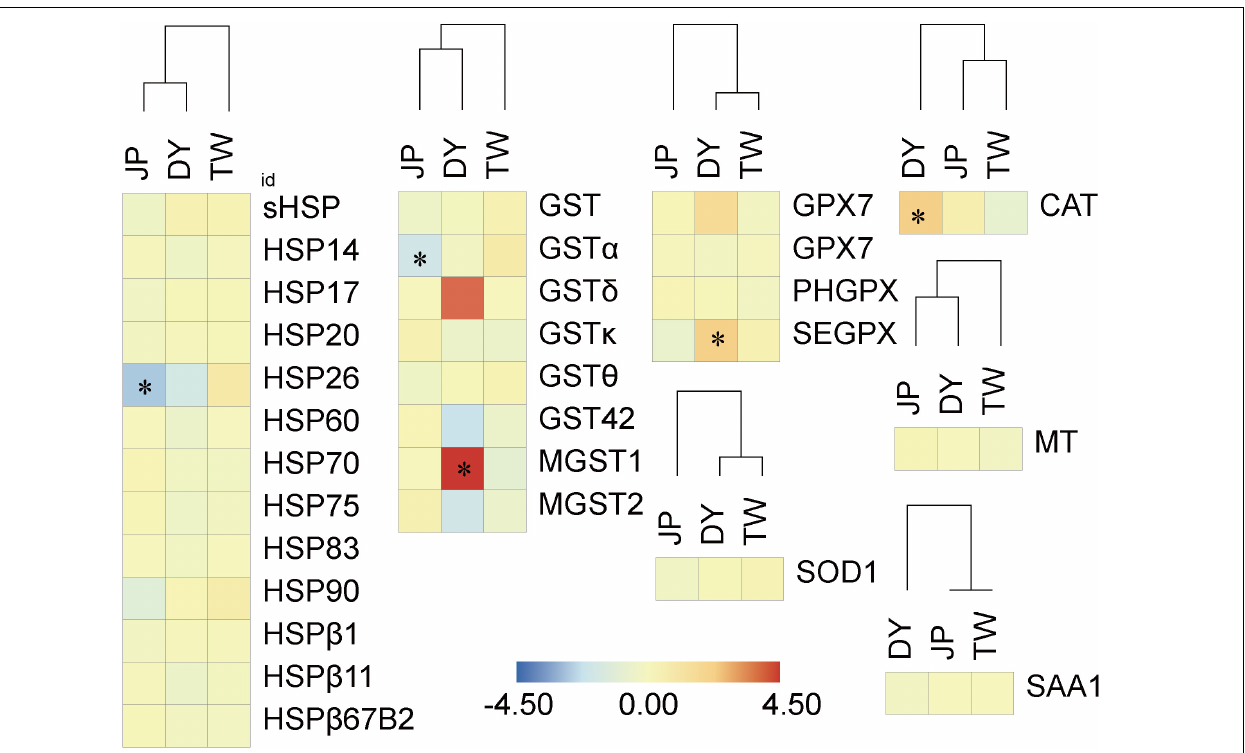
FIGURE 10 | Relative expression of stress response genes in the three H. diversicolor genotypes. * represents the significant difference of the gene expression level compared to the